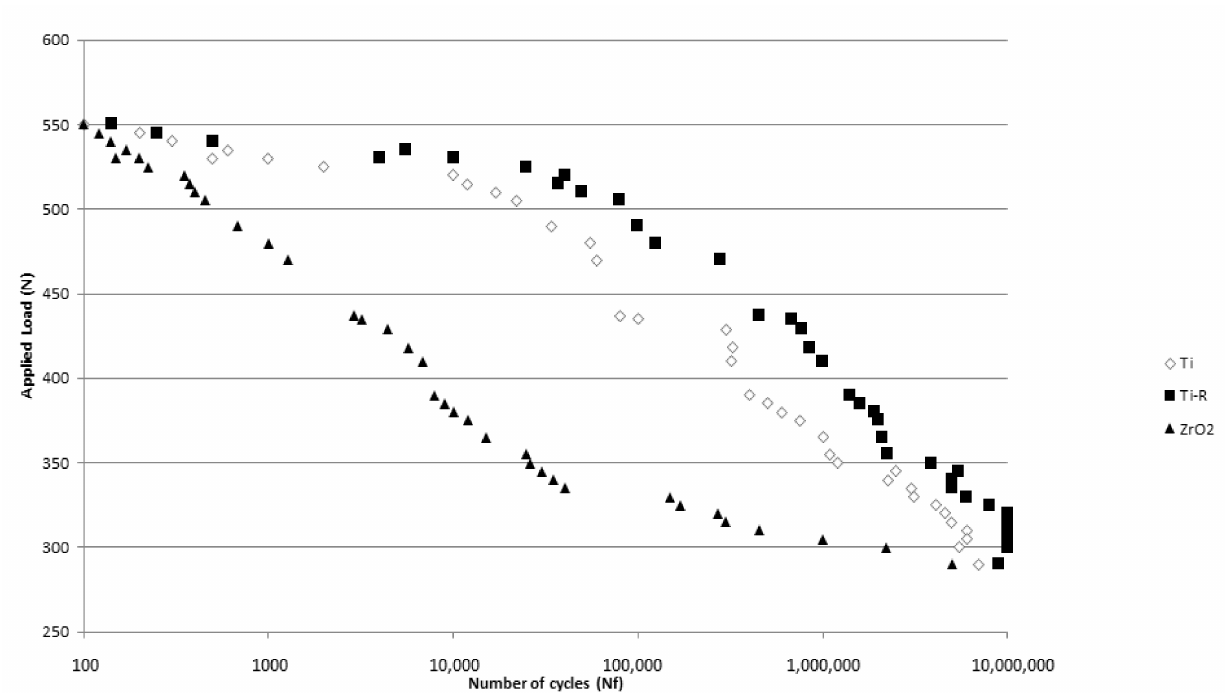
Figure 4. S–N curves for the different dental implants